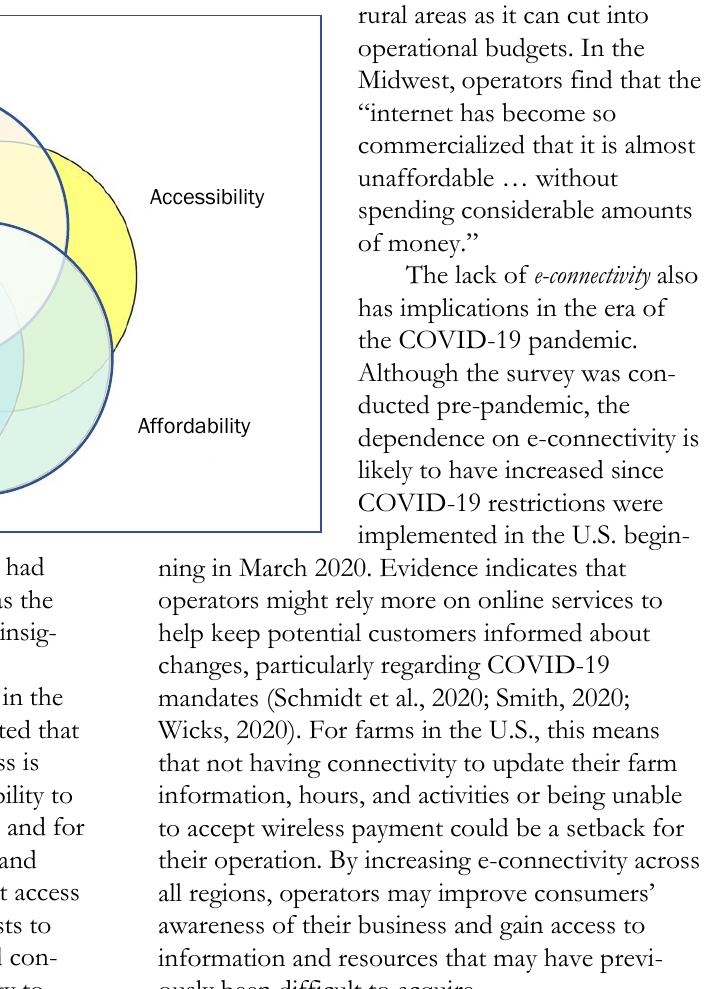
Figure 4. Limits to Access Due to